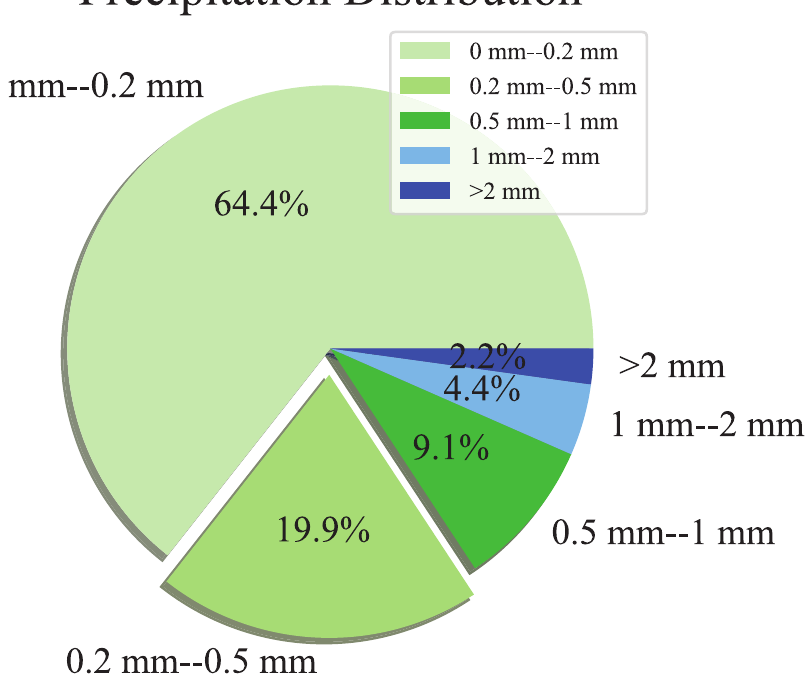
Figure 7. Precipitation statistics in the